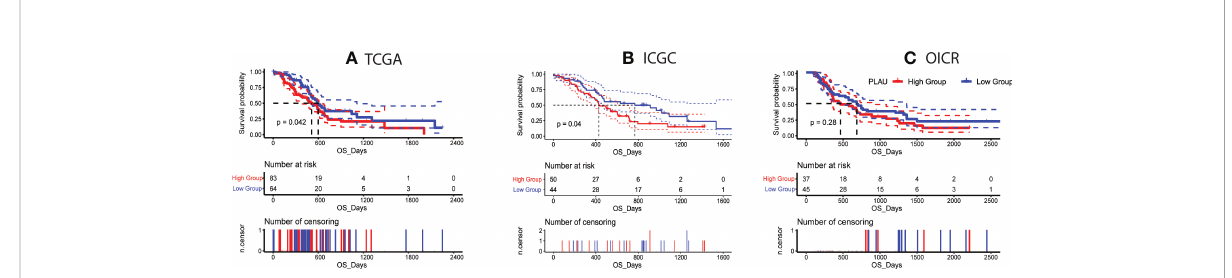
FIGURE 3 Correlation of PLAU gene expression with survival in PDAC. (A, B) Kaplan-Meier survival curves show that high PLAU expression correlated with signi fi cantly poorer overall survival (OS) in the TCGA and ICGC PDAC cohorts (log-rank test, P < 0.05), (C) but this was not evident with the OICR-PDAC cohort (log-rank test, P =